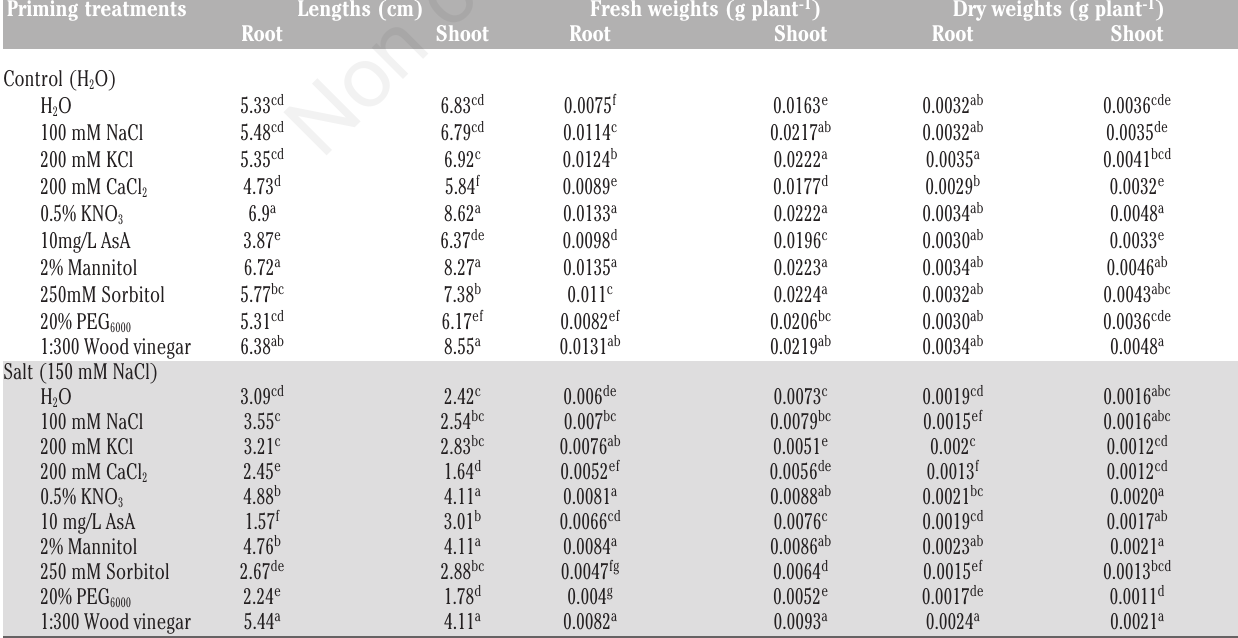
Table 1. Growth characteristics of 10-day-old seedlings grown from seeds primed with 10 chemical priming treatments, germinated and grown under control (H O) and salt-stressed (150 mM NaCl) conditions. 2 Priming treatments Lengths (cm) Fresh weights (g plant -1 ) Root